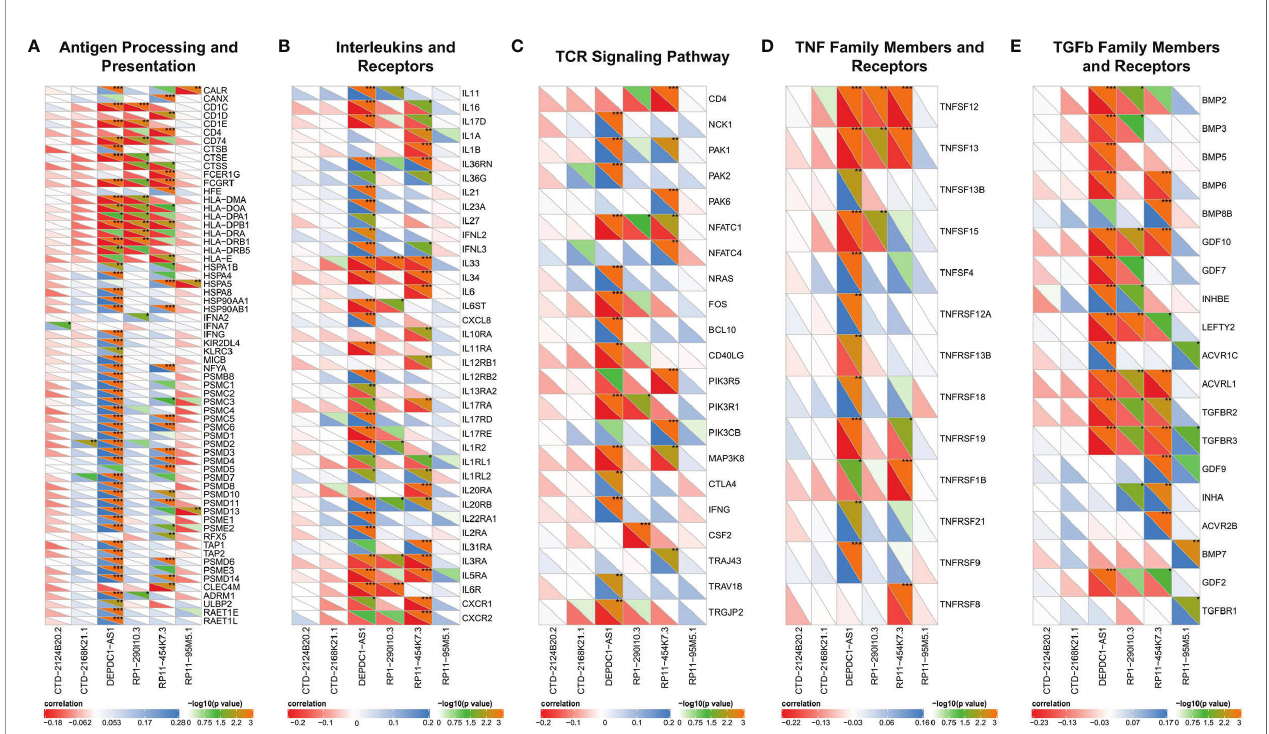
FIGURE 5 | Correlated immune categories with lncRNAs in the prognostic model. (A – E) Correlation analysis between lncRNAs with gene expression in (A) antigen processing and presentation category, (B) interleukins and receptors category, (C) TCR signaling pathway category, (D) TNF family members and receptors category, and (E) TGFb family members and receptors category. The abscissa represents the lncRNAs, and the genes in the immune categories are on the ordinate. The lower left half triangle represents correlation: red means negative correlation, while blue implies positive correlation. Darker color means stronger correlation. The upper right semi- triangle is the value of − log10 ( P -value). A larger value implies the darker the color. Spearman test was used for correlation analysis. * P < 0.05; ** P < 0.01; *** P <